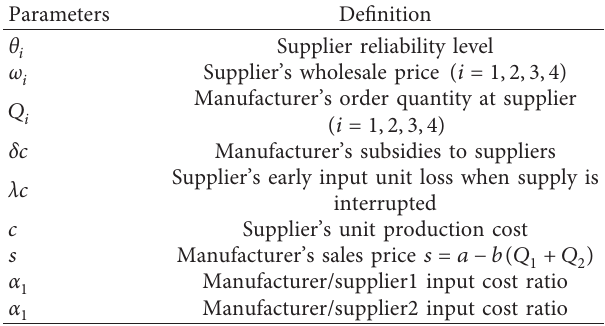
Table 1: Main parameters and parameter description.